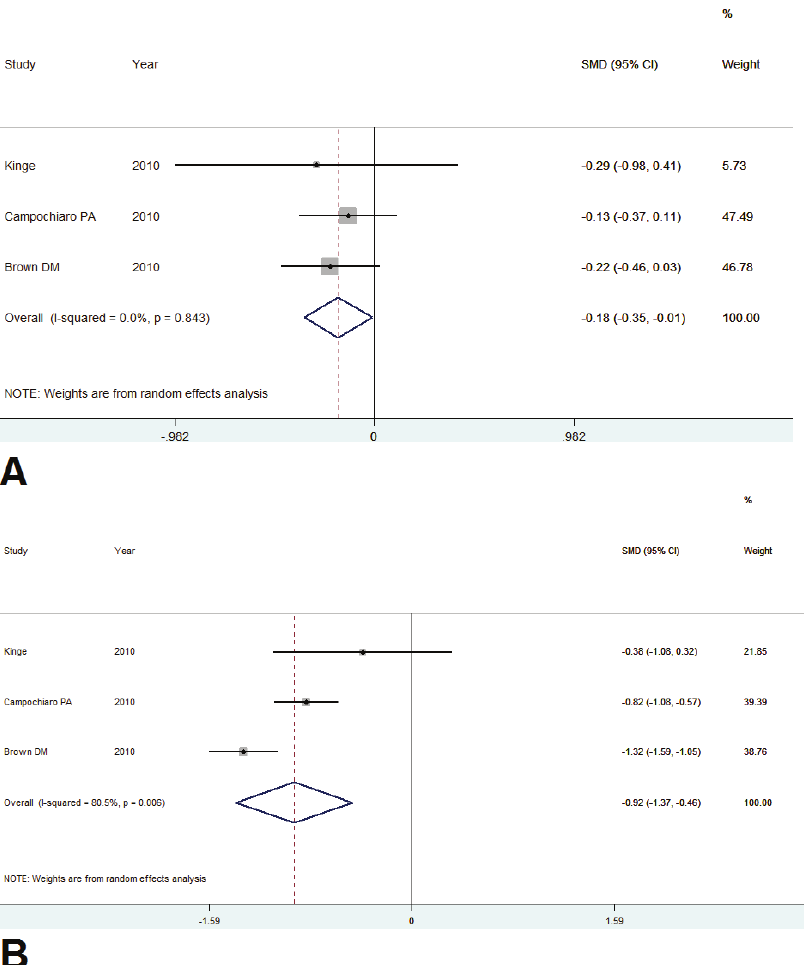
Figure 2. Forest plot displaying pooled summary estimates with ranibizumab treatment versus sham injection at 24 weeks. (a) Regarding VA, there was no significant heterogeneity (I2 = 0%, p = 0.84). Due to small number of included studies, either fixed- effect or random-effect analysis was applied or the overall 95%CI was meaningful (-0.35 to -0.01). (b) Regarding CMT, there was significant heterogeneity (I2 = 80%, p < 0.01), hence, the random-effect model was used and the overall 95%CI was meaningful (-1.37 to -0.46). CI, confidence interval; CMT, central macular thickness; VA, visual